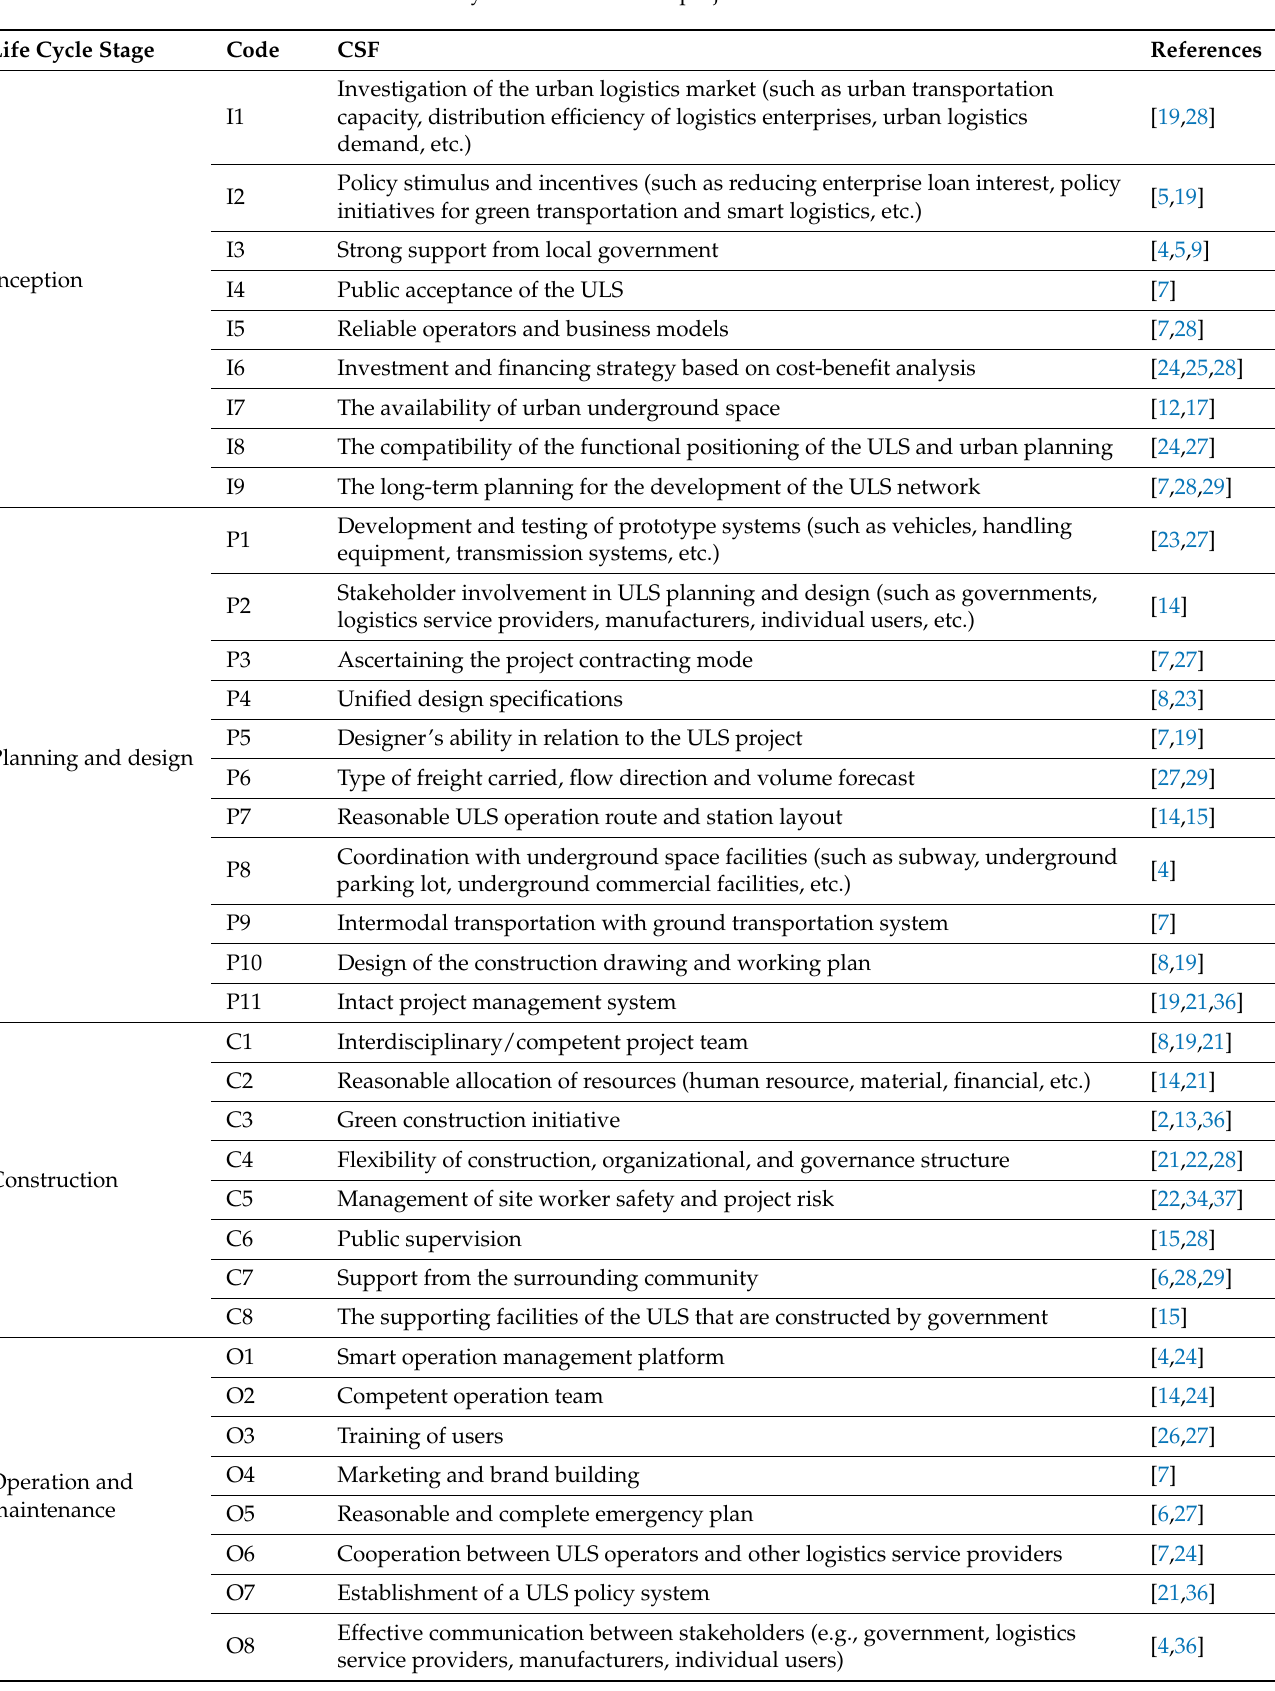
Table 3. Summary of the CSFs of ULS